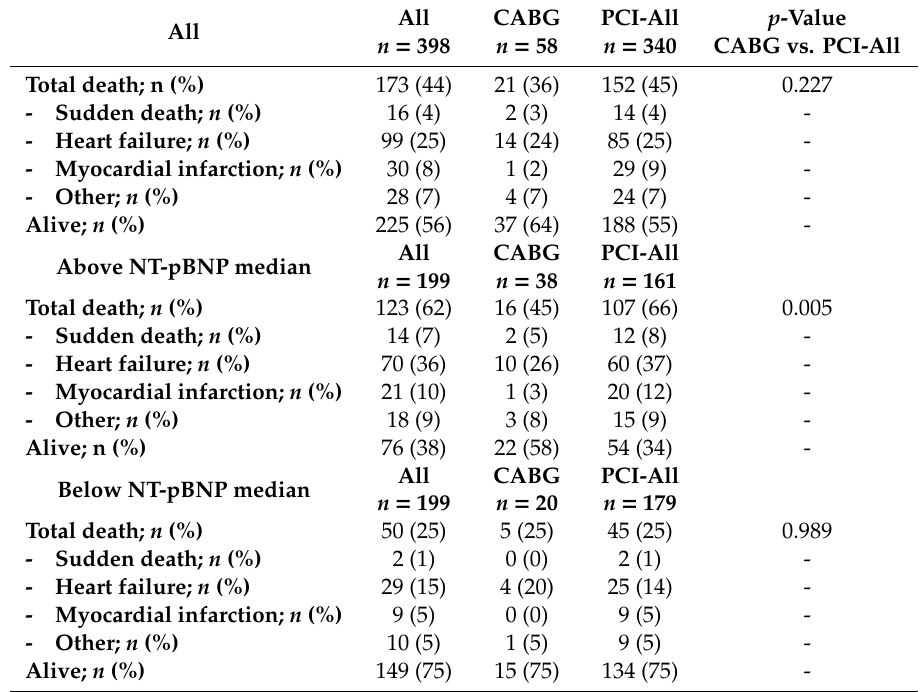
Table 3. Cause of